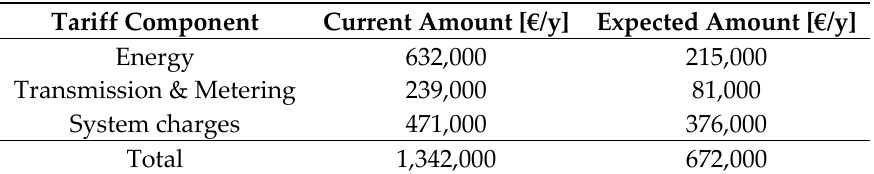
Table 5. Energy costs